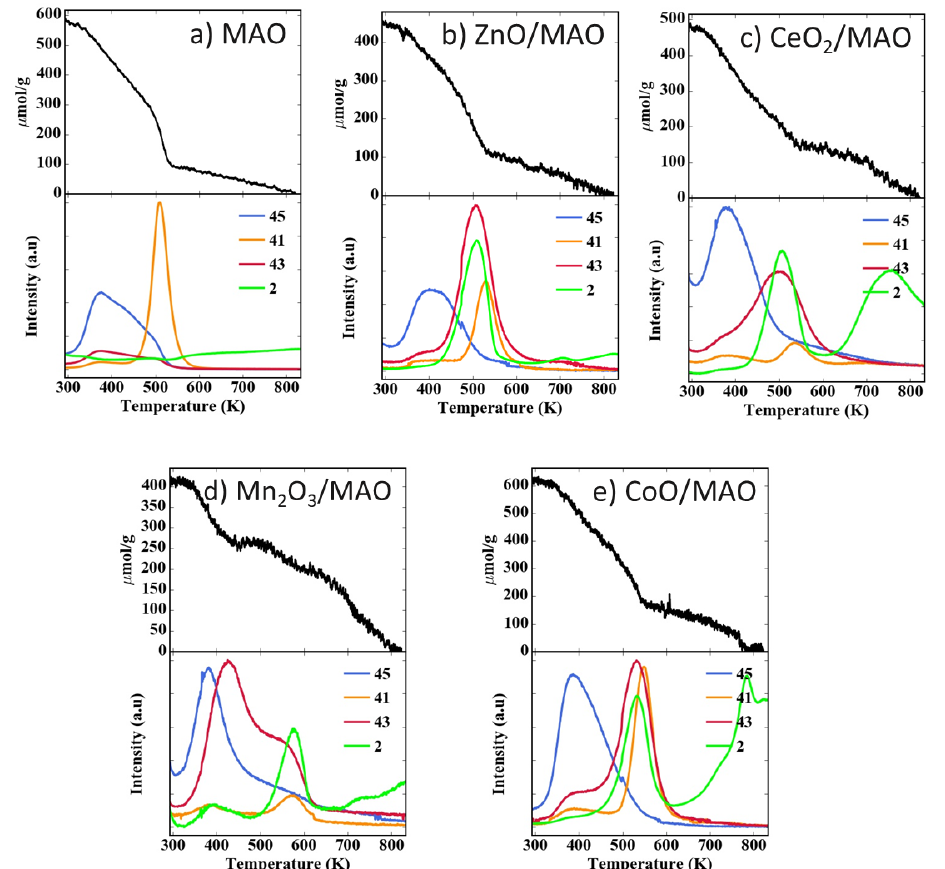
Figure 3. Temperature programmed desorption (TPD) and thermogravimetric analysis (TGA) re- sults for 2-propanol on the supports used in this study, ( a ) MAO, ( b ) ZnO/MAO, ( c ) CeO 2 /MAO, ( d ) Mn 2 O 3 /MAO, ( e ) CoO/MAO. Characteristic mass fragments: 2-propanol (m/e = 45), propene (m/e = 41), and acetone (m/e = 43).